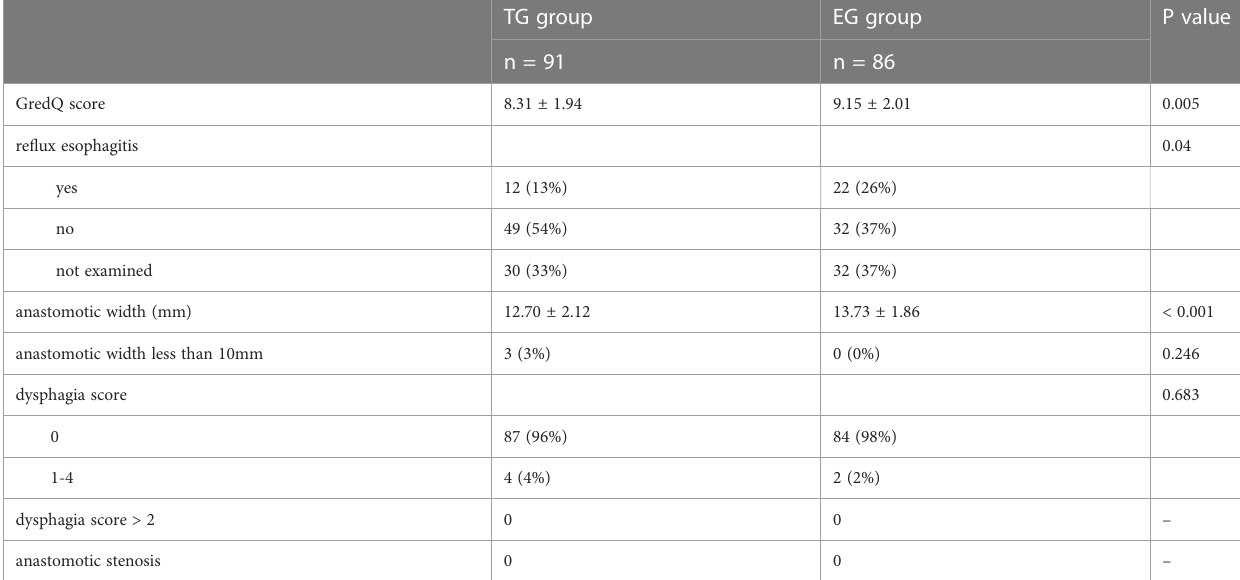
TABLE 6 Postoperative quality of life (2 years after surgery).